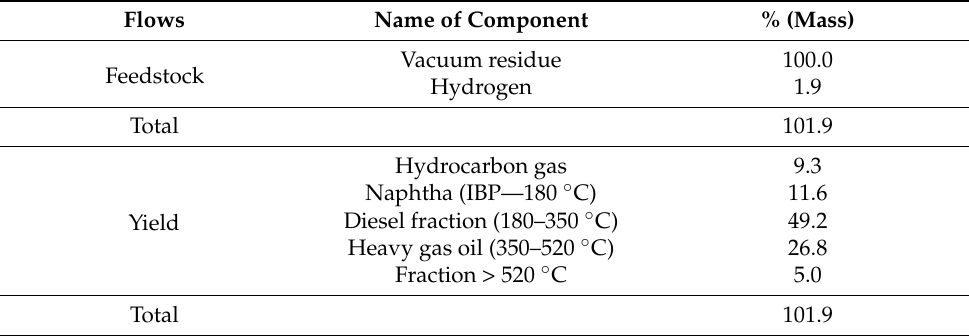
Table 4. Material balance of hydroconversion for upgrading of vacuum residue from Western Siberia